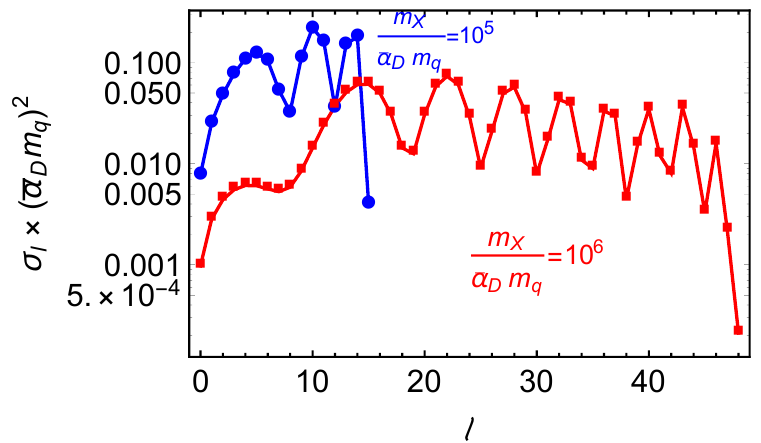
Figure 4. The rearrangement cross section for each partial wave l , for two di(cid:11)erent values of m X , with E i = 0 : 6 E b . All partial waves in the incoming state contribute up to a maximal l (cid:17) l max (cid:24) k i a q .